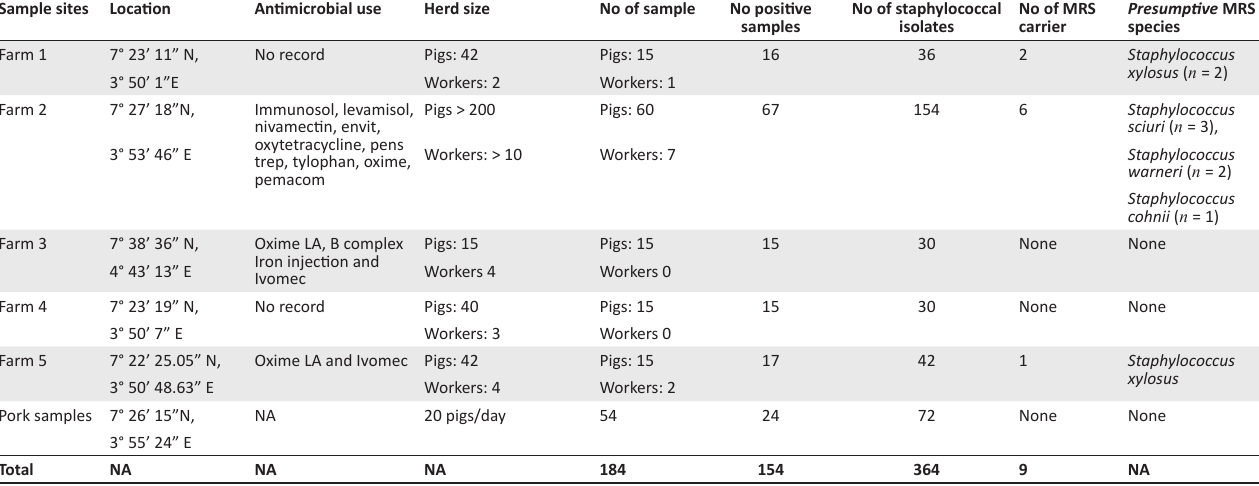
TABLE 1: Summary of the sampling, antimicrobial use, Staphylococcus species, and methicillin-resistant isolates recovered in this study. Sample sites